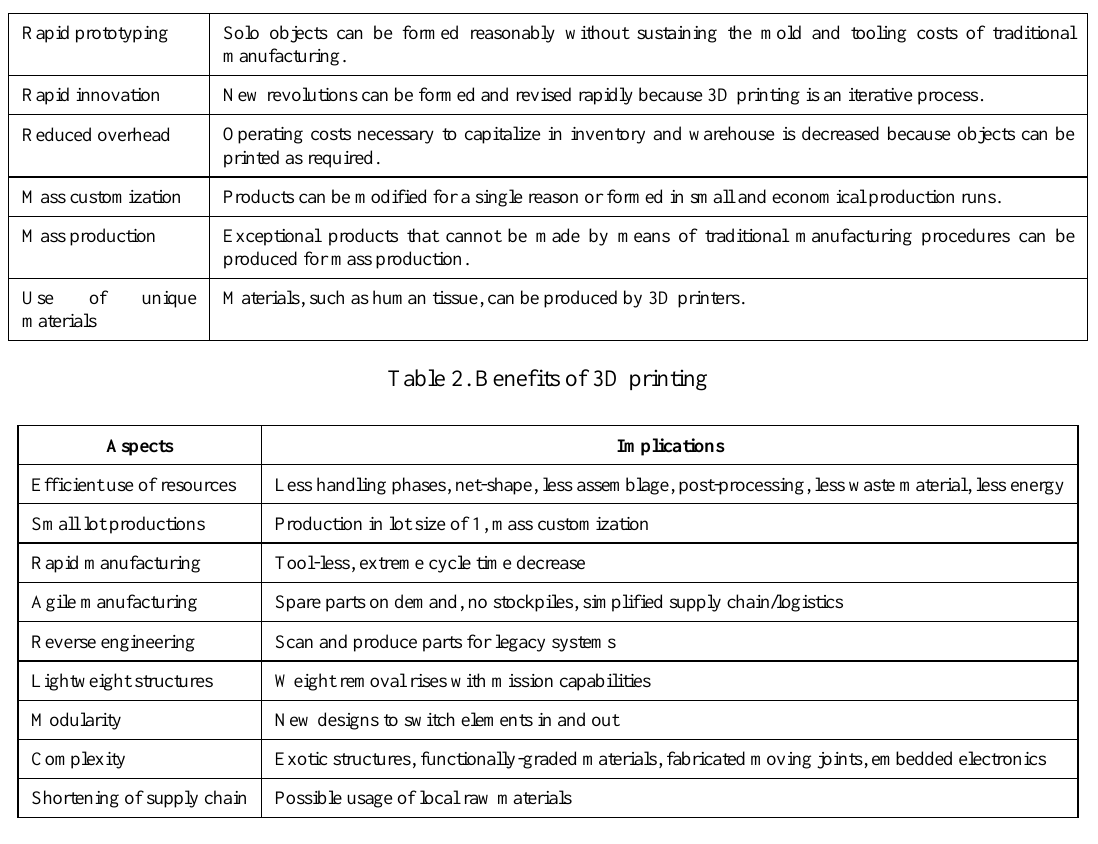
Table 3. Potential AM implications for